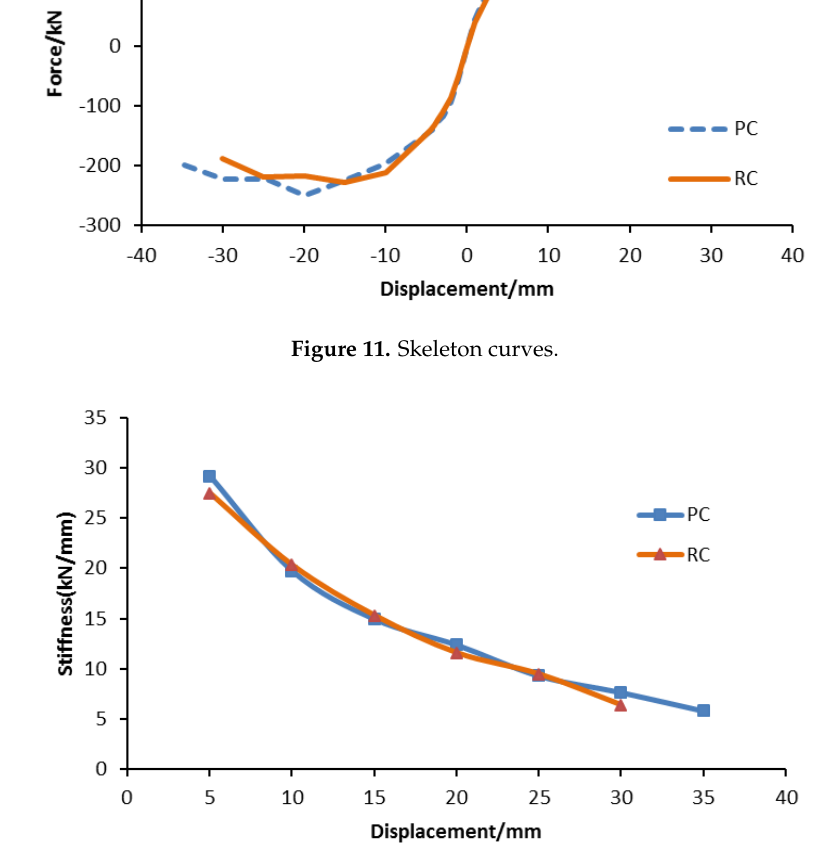
Figure 13. Equivalent viscous damping coefficient curves. Table 3. Displacement ductility coefficient. Specimen